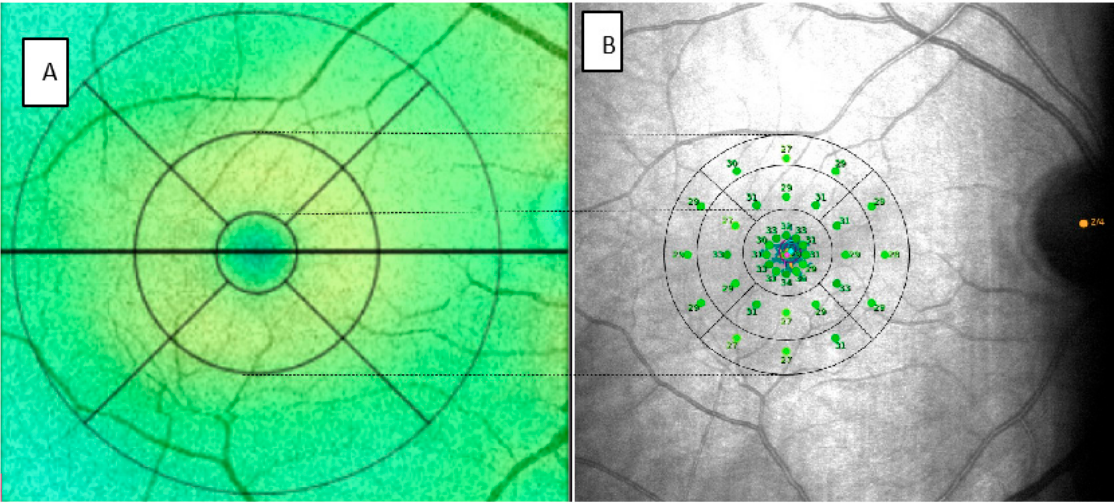
Figure 2. Images provided SS-OCT ( A ) and MAIA ( B ) of the same patient modified to represent the correlation between the two. SS-OCT: swept source optical coherence tomography, MAIA: macular integrity assessment.